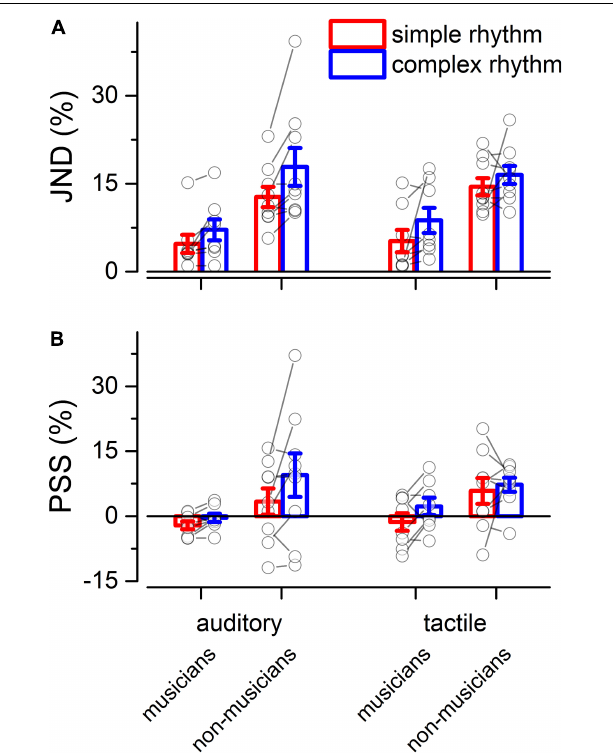
FIGURE 2 | Experiment 1: temporal order judgment task. (A) Grand-average just-noticeable-difference (JND) for simple (red) and complex rhythms (blue) for all the modality conditions and expertise. Dots indicate individual data, error bar indicates ± 1 S.E.M. (B) Same as (A) but for point-of-subjective-simultaneity (PSS).